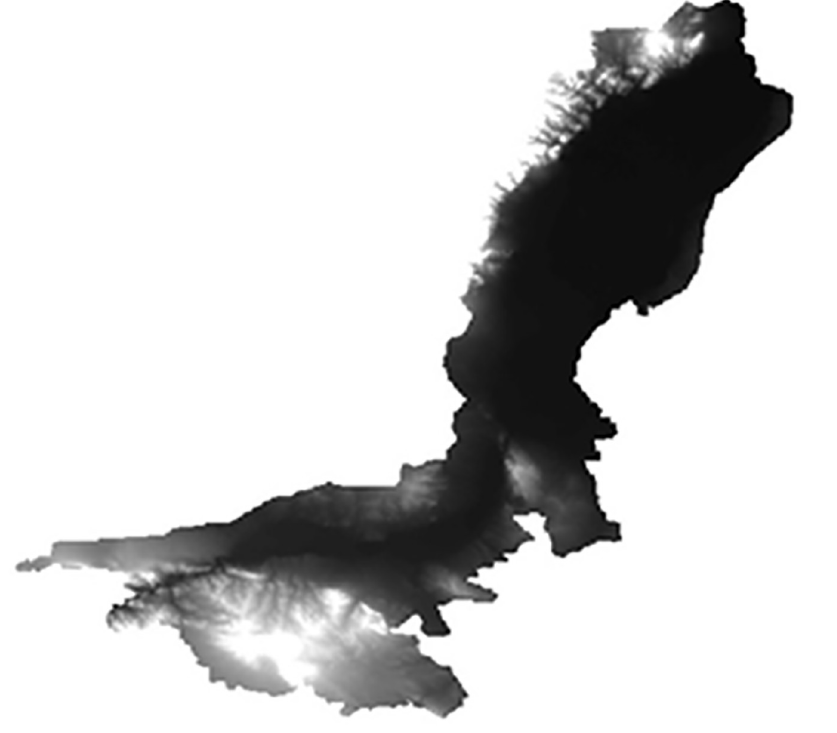
Fig 1. DEM map of Ningxia section of the Yellow River